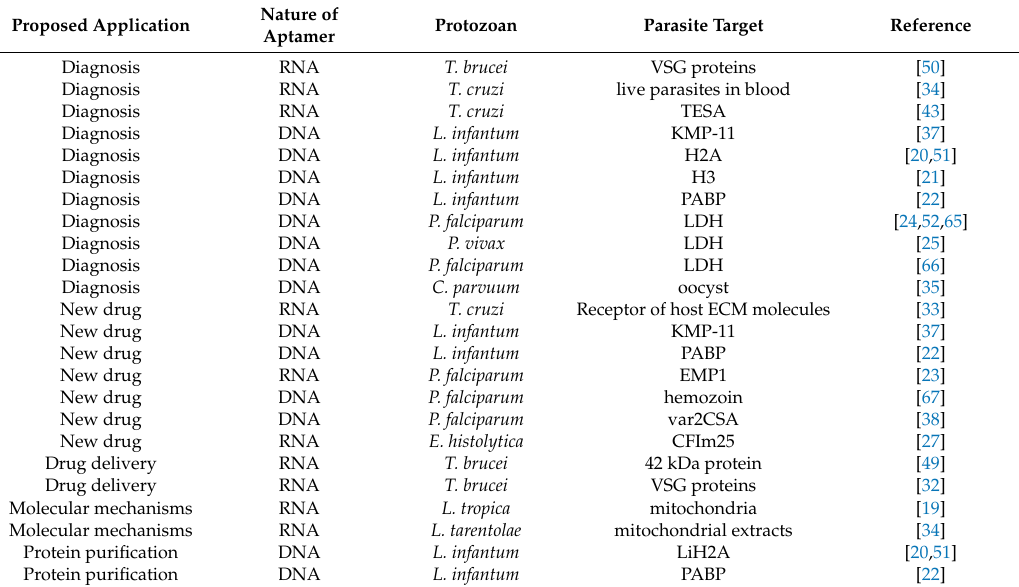
Table 3. Proposed applications for parasite-specific